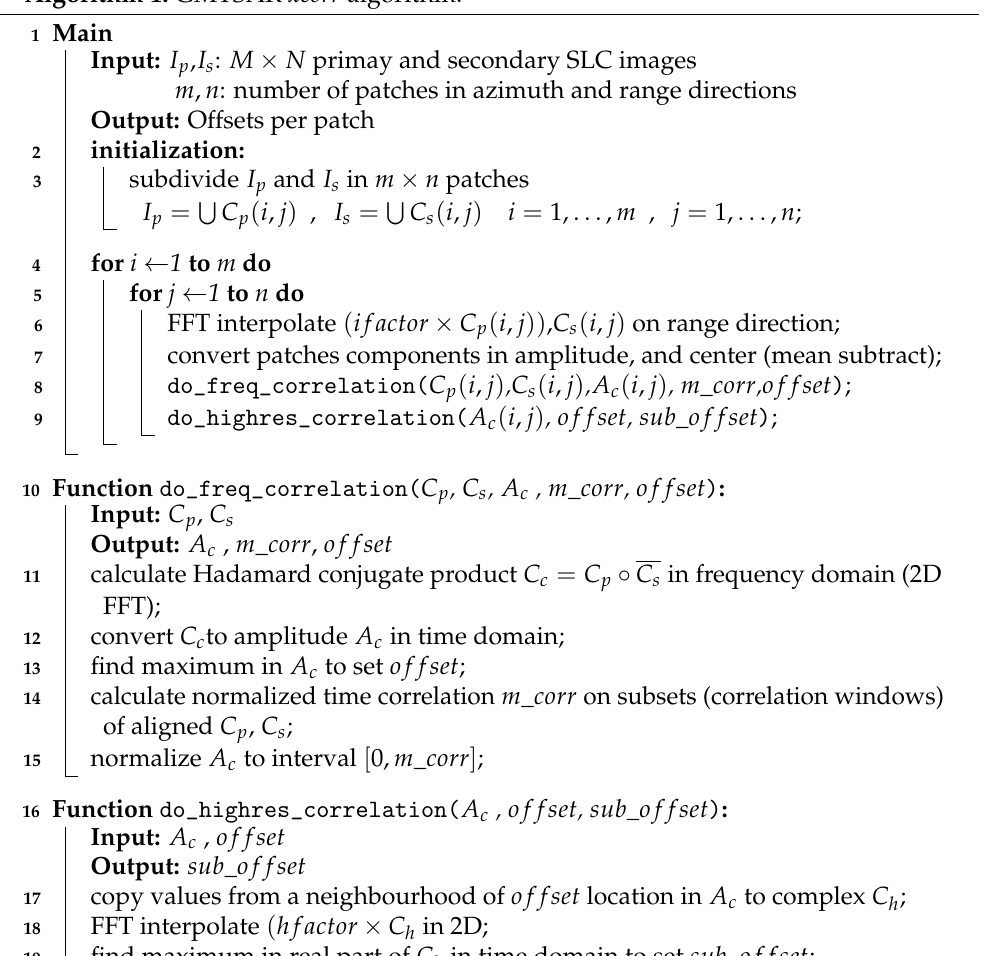
Algorithm 1: GMTSAR xcorr